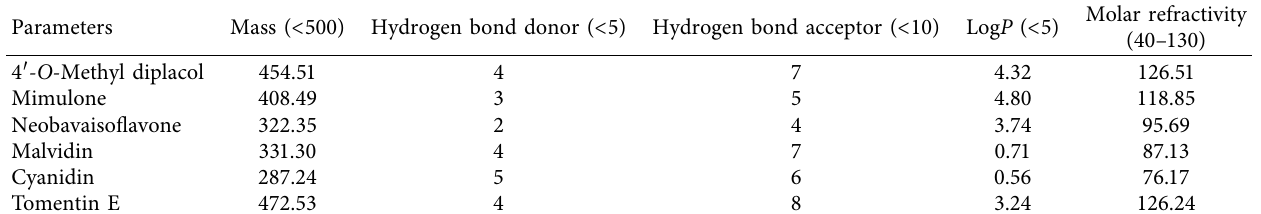
Table 2: Physiochemical parameters of the selected 6 favonoids predicted by using SwissADME. Parameters